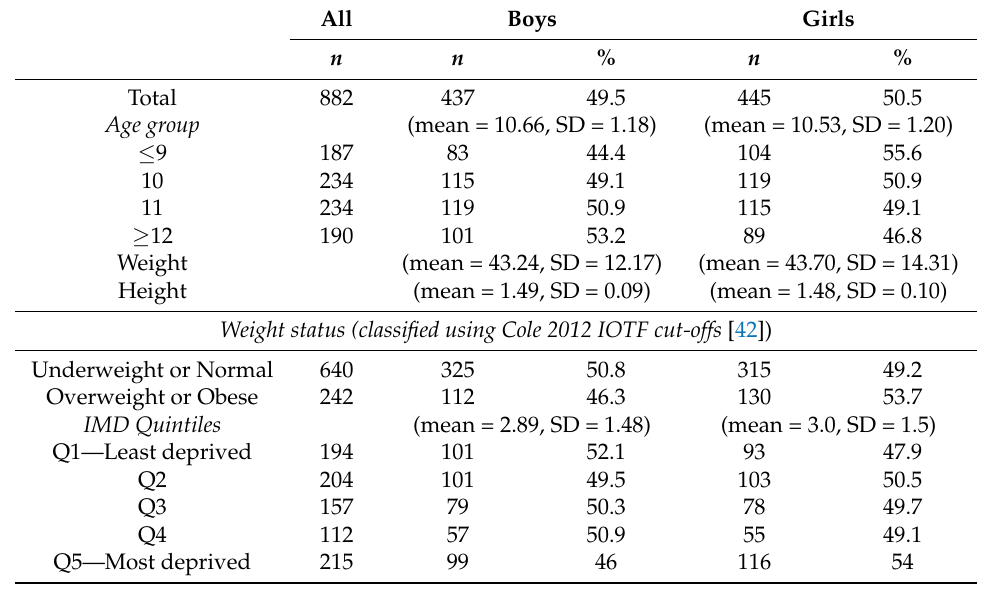
Table 1. Socio-demographic and weight status characteristics of study